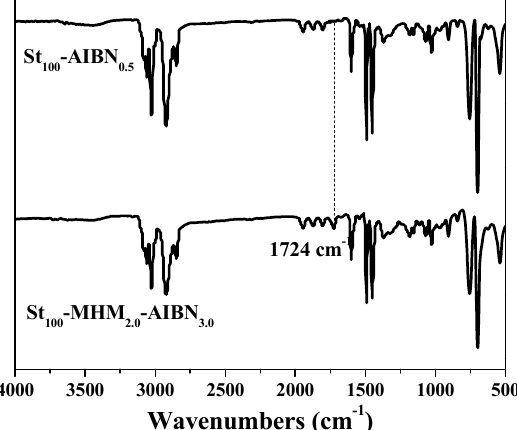
Figure 1. Typical Fourier transform infrared (FT-IR) spectra of the polystyrenes.